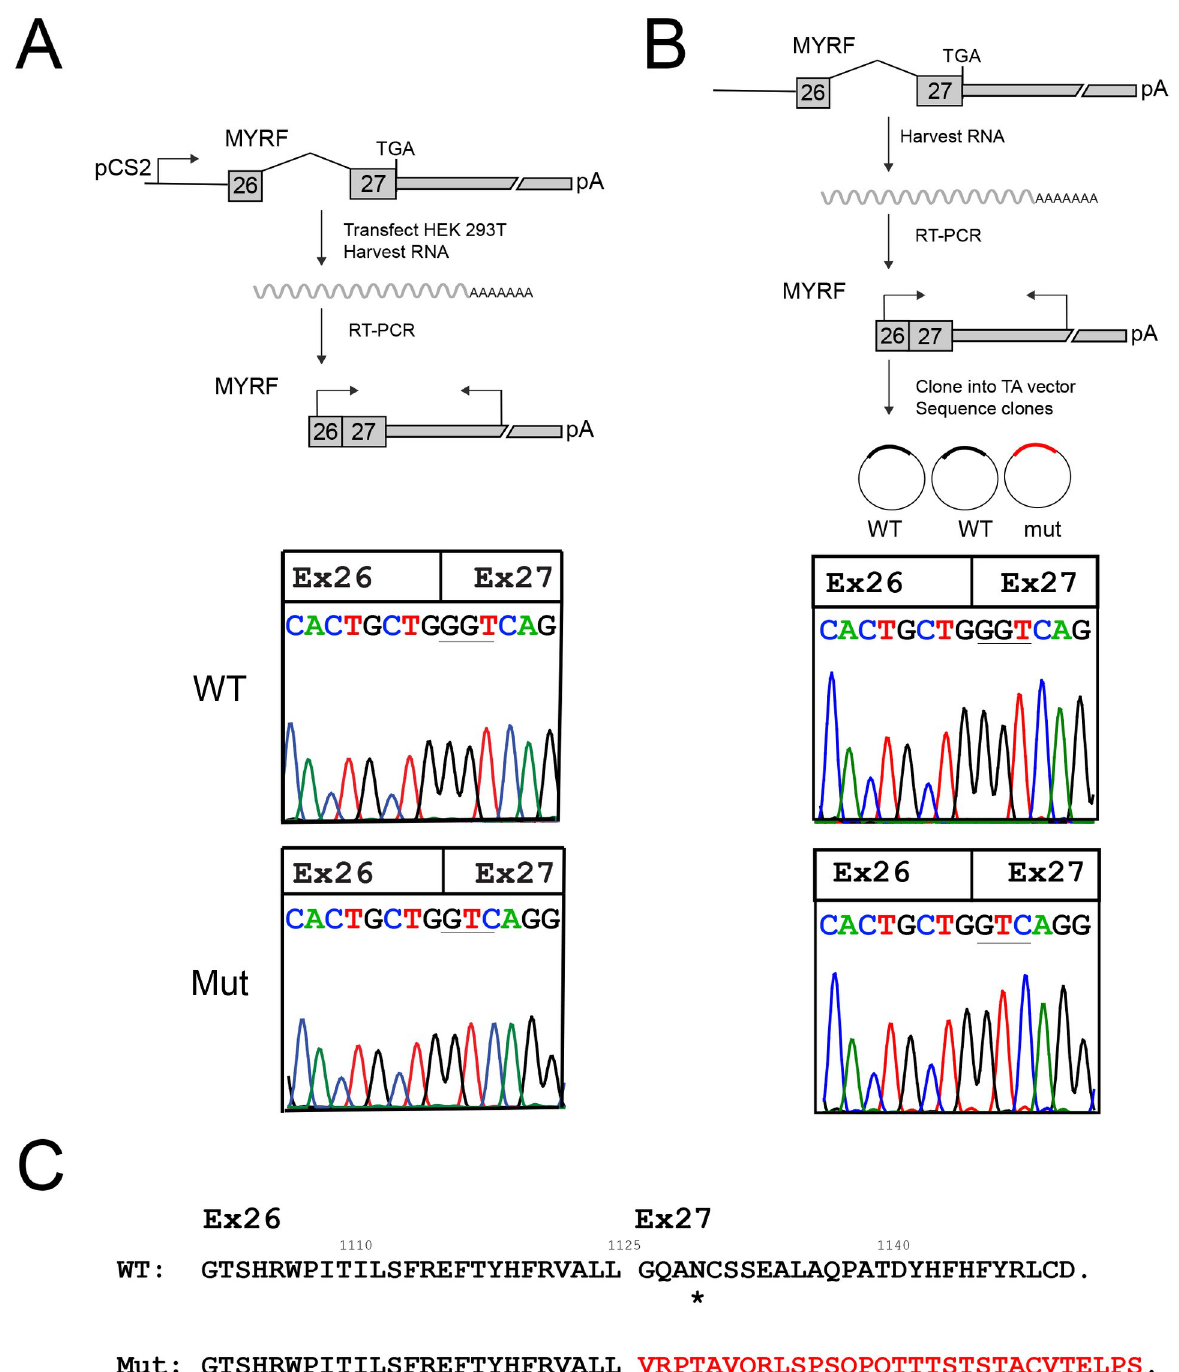
Fig 4. MYRF c.3376-1G > A variant disrupts mRNA splicing and produces a stable RNA species. (A) Minigene splicing assay. Schematic diagram showing the design of the minigene assay, and sample chromatograms showing the wild-type and mutant cDNA species isolated from this assay. A single splice product was generated for each form, wild-type (WT) and mutant (Mut) RNA. The splice product for the mutant form uses a splice acceptor site one base pair downstream of the original splice site and creates a frameshift (see Fig 3C ). (B) RT-PCR from individual IV-22 blood RNA. Schematic diagram of the experiment is shown with sequence chromatograms from representative cloned RT-PCR products demonstrated. The mutant clones comprised 42% (3/7) of the spliced RNA species. (C) Predicted effect of splice site mutation on C-terminal amino acid sequence, showing frameshift and replacement of the final 26 amino acids with 30 different amino acids. A putative glycosylation site is marked with a � .